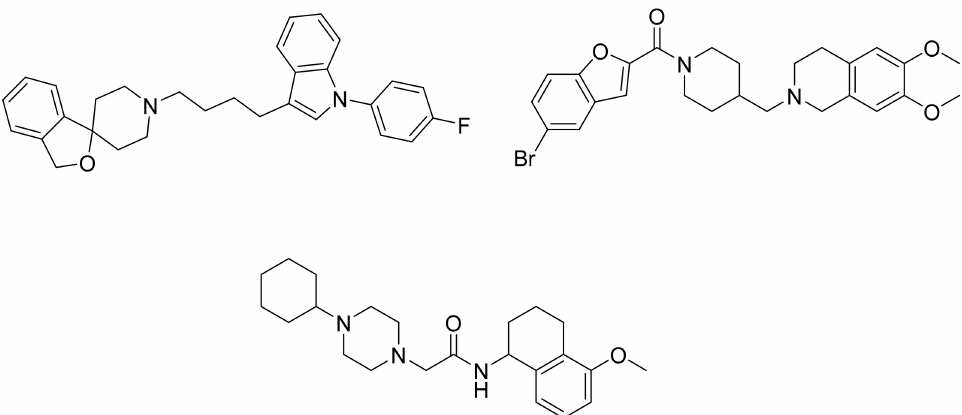
Figure 4. Three representative structures were selected as queries based on their high S2R binding affinity and conformational